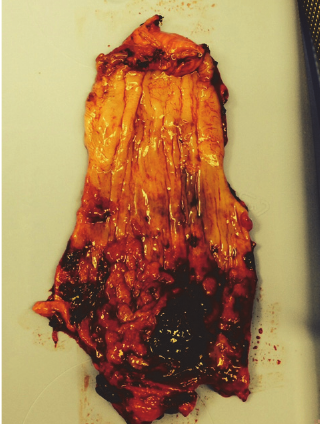
Figure 3: Submucosal hemorrhages and ulceration of the esopha-